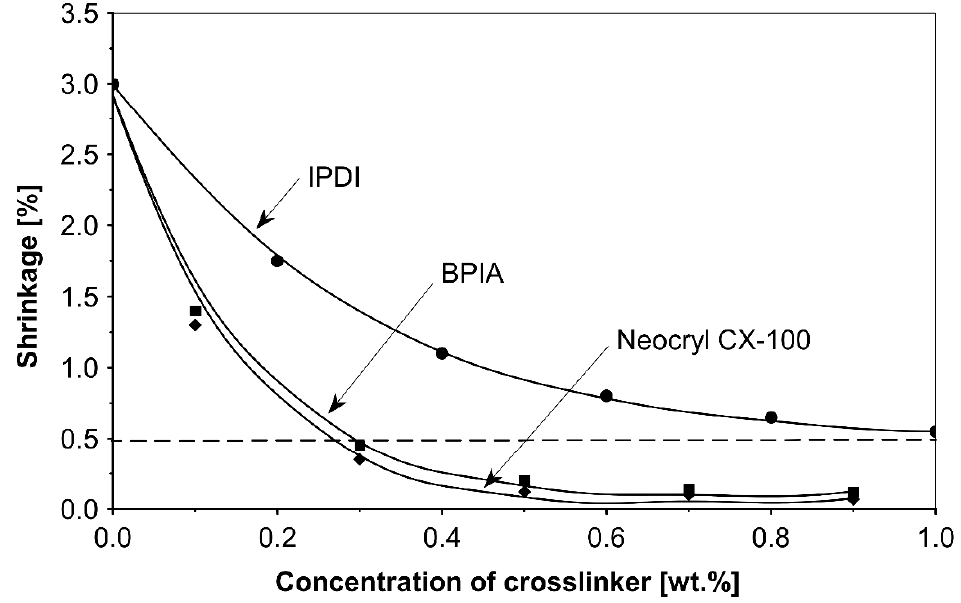
Figure 3. Shrinkage of the acrylic PSAs crosslinked using IPDI, BPIA and Neocryl